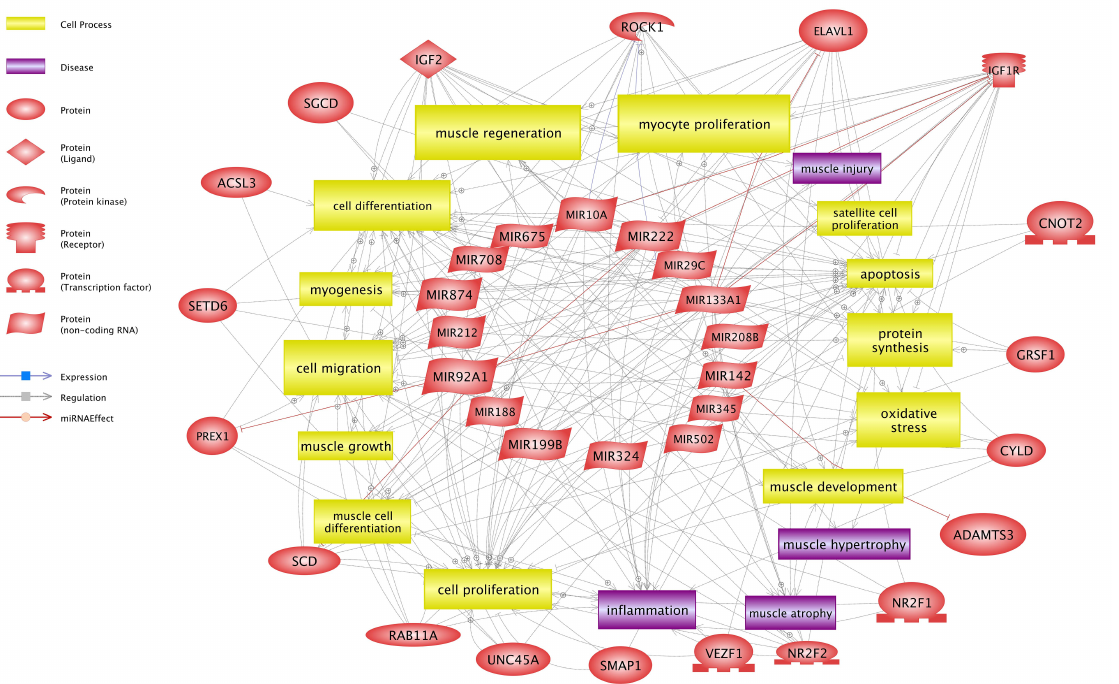
Figure 2. miRNAs and their differentially expressed target genes (DET) in combination with processes that may be associated with muscle tissue during injury and